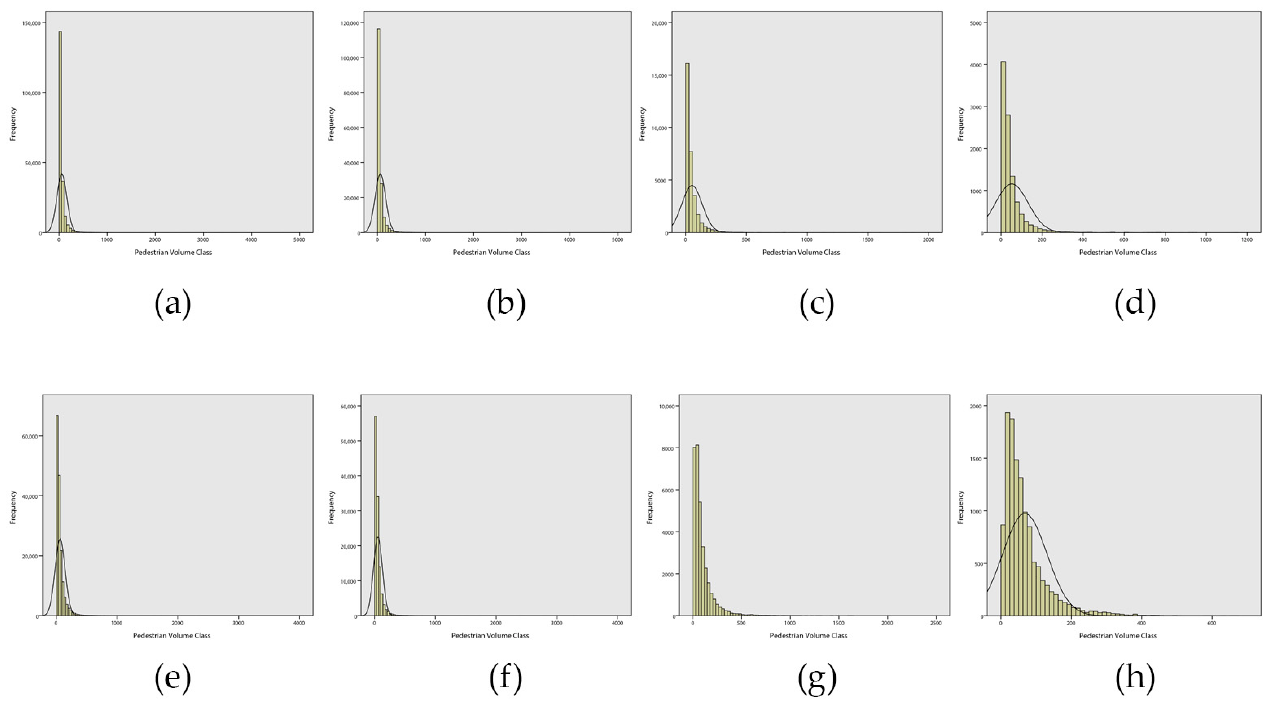
Figure 3. Histogram of PV: ( a ) Model 1; ( b ) Model 2; ( c ) Model 3; ( d ) Model 4; ( e ) Model 5; ( f ) Model 6; ( g ) Model 7; ( h ) Model